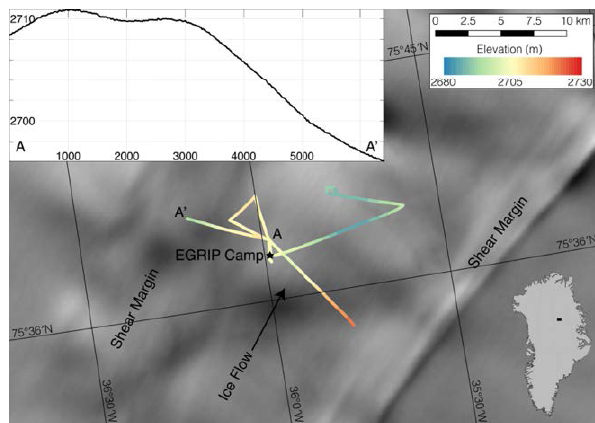
Figure 3. MODIS image of the Northeast Greenland Ice Stream and the EastGRIP camp with rover mission paths colored by surface elevation of the ice as determined from the CIC rover GPS (Haran et al.,